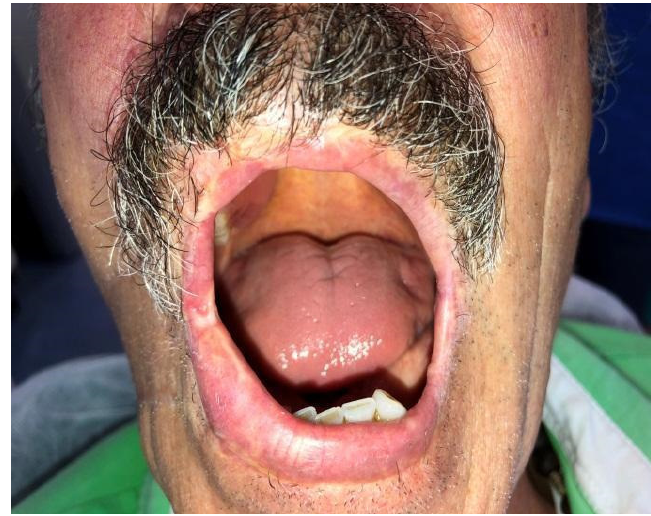
Figure 9. Case 2: Follow up at six months. Dynamic position, frontal view.